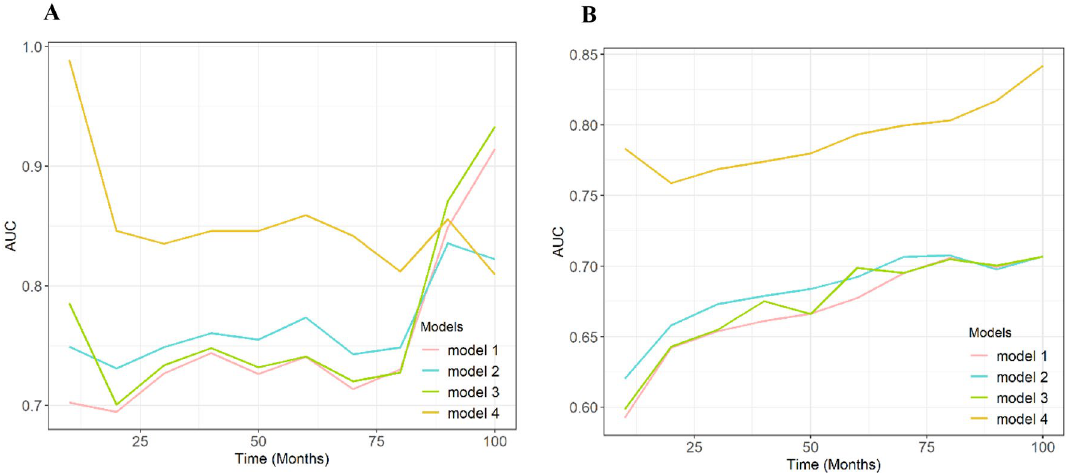
Figure 4. AUC curves of the prediction models. ( A ): Training cohort; ( B ): Testing cohort; model 1, Cox-TNM, model 2, Lasso-Cox; model 3, RSF-TNM; model 4, RSF.